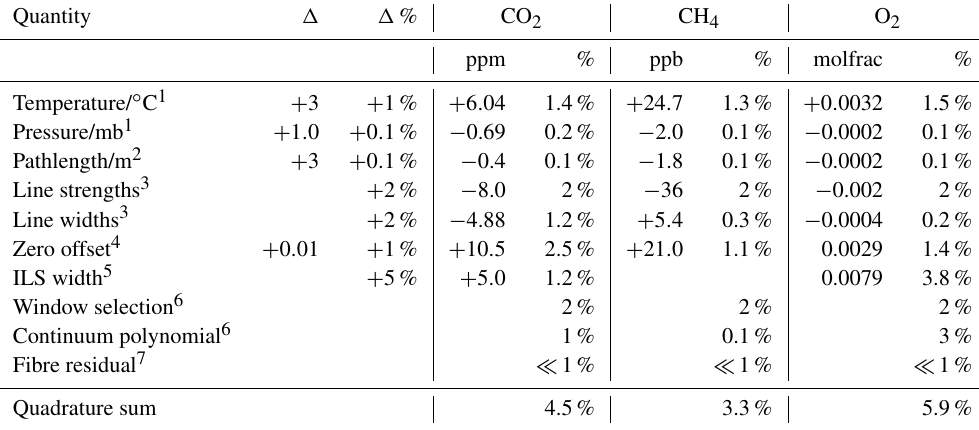
Table 3. Sensitivity of retrieved mole fractions to retrieval inputs in the OP-FTIR measurements. Each input parameter or choice was varied by an estimate of its uncertainty in the MALT spectrum analysis and its effect on retrieved mole fractions